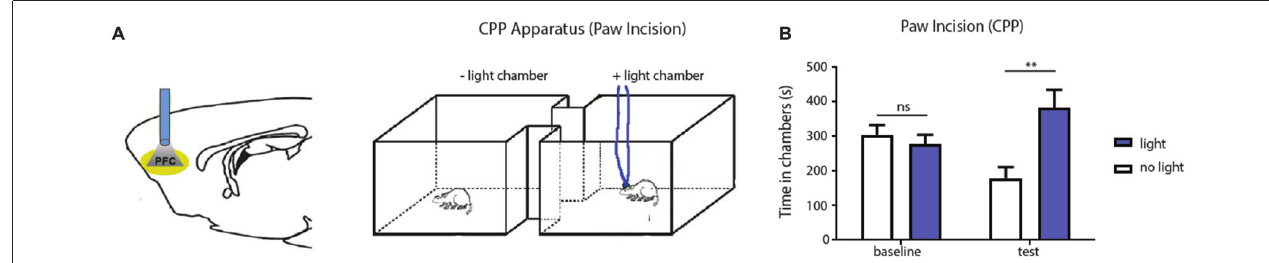
FIGURE 4 | PFC activation reduces affective symptoms of pain in the PI model. (A) Schematic showing optogenetic activation of PFC neurons during the conditioned place preference (CPP) for PI-treated rats. One chamber was paired with optogenetic activation, and the other chamber was paired without light activation. (B) CPP results showing that PI rats, after conditioning, demonstrated a significant preference for the chamber associated with PFC activation. n = 7, p < 0.0012. Two-way ANOVA with repeated measures and Bonferroni post-test. Error bars show mean and SEM. ∗∗ p < 0.01.